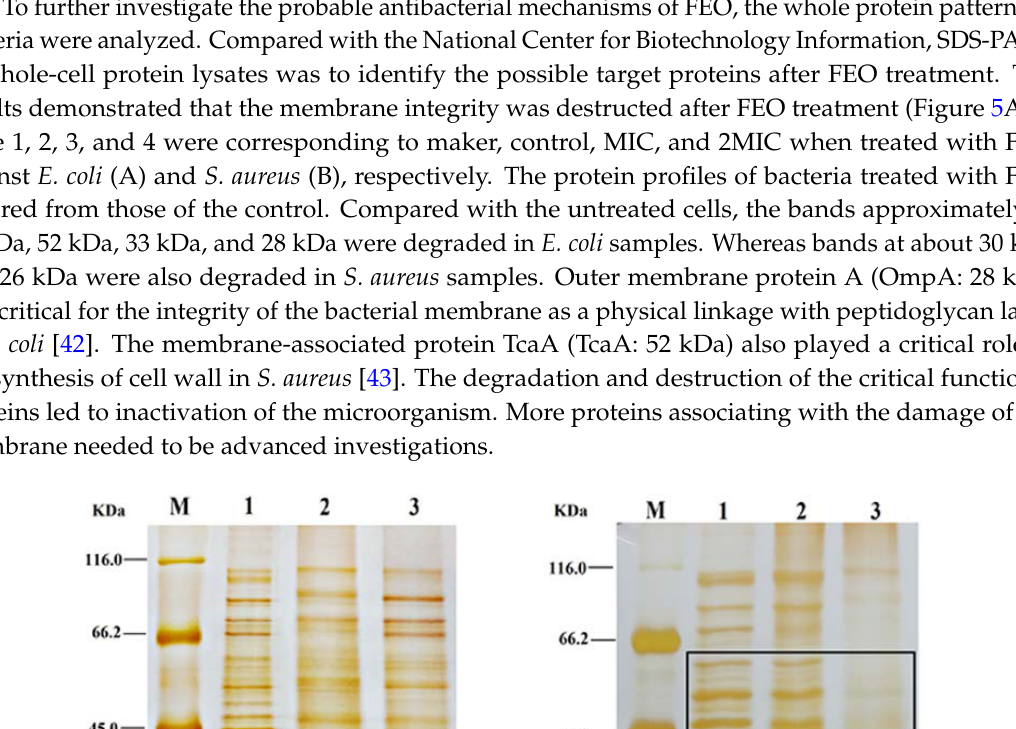
Table 2. Effects of the FEO on cellular of leakage E. coil and S. aureus. Bacteria